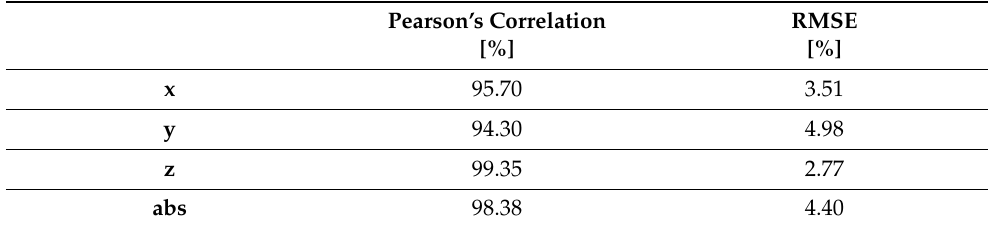
Table 2. Pearson’s correlation and RMSE computed for real and simulated angular velocity data.